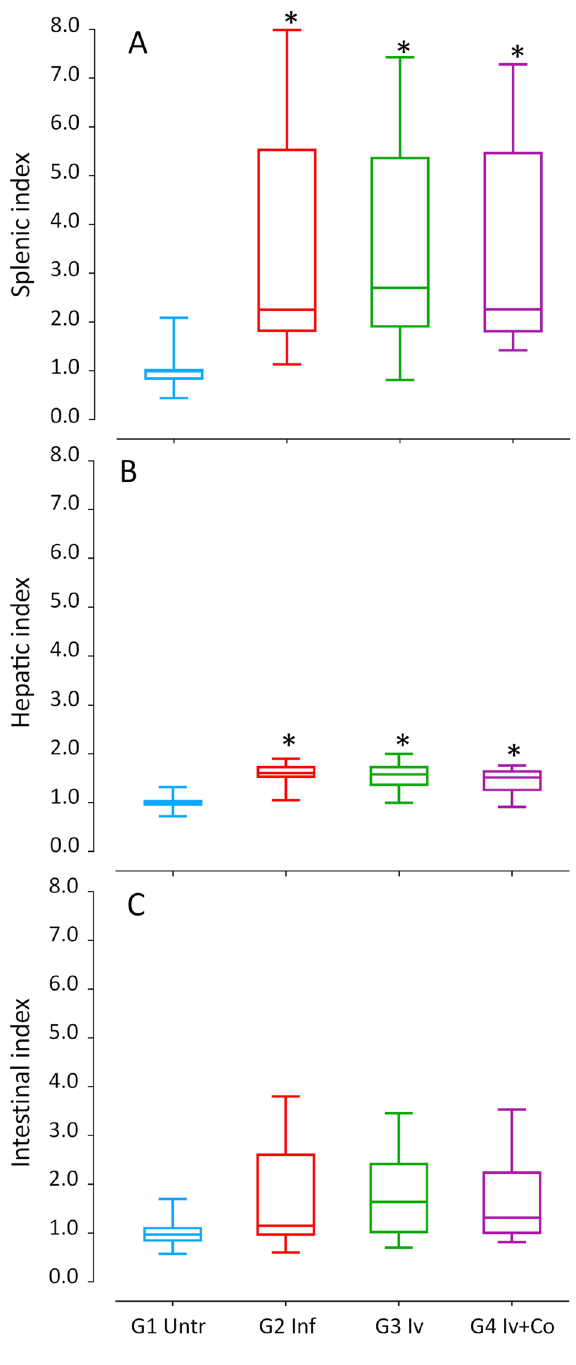
Figure 6. Splenic index ( A ), hepatic index ( B ) and intestinal index ( C ) of mice treated with ivermectin (Iv) and Ivermectin + cobicistat (Iv + Co) and infected with 150 cercariae by S. mansoni (Inf) at 8 weeks post-infection. *Statistically significant differences p < 0.05 compared to untreated controls